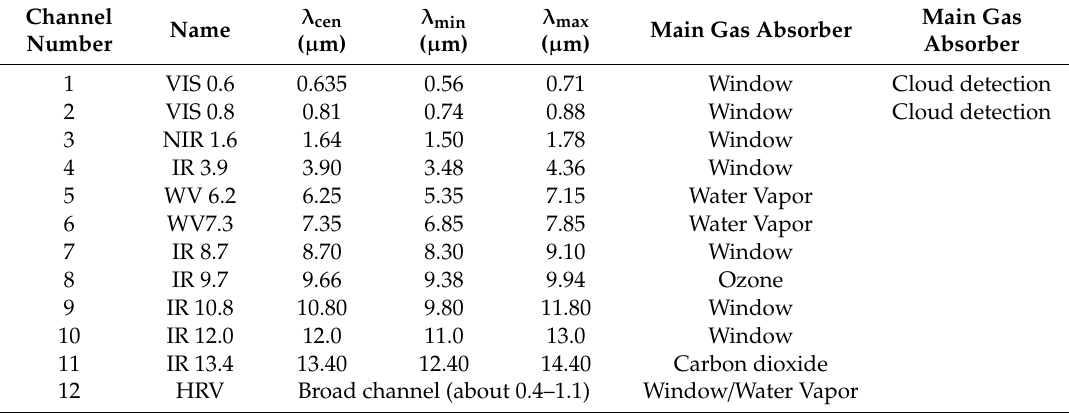
Table 1. Spinning enhanced visible and infrared imager (SEVIRI)’s channels characteristics. Other than channel number and name, the central, minimum, and maximum wavelength ( λ cen , λ min , and λ max , respectively) are reported, as well as the main gas